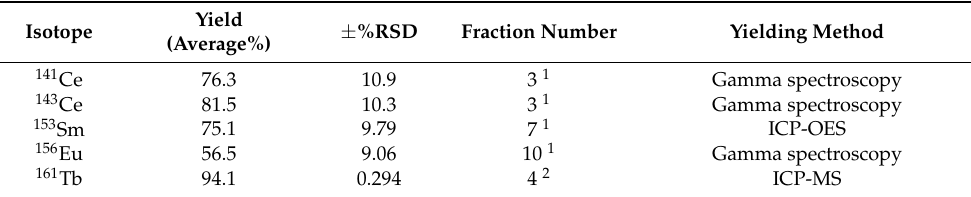
Table 3. Chemical yields for the separated lanthanide fractions sent for radiometric detection (gamma spectroscopy or LEPS). Samples were run in quadruplicate.